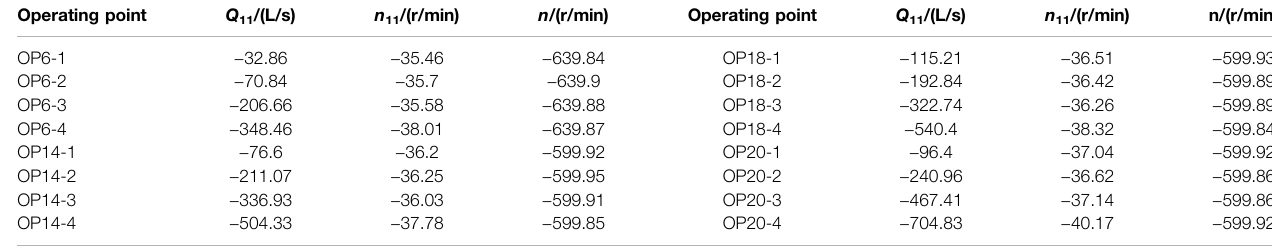
TABLE 6 | Table of operating point in pump mode. (A negative value indicates that the running direction of the unit in the test is the pump direction).